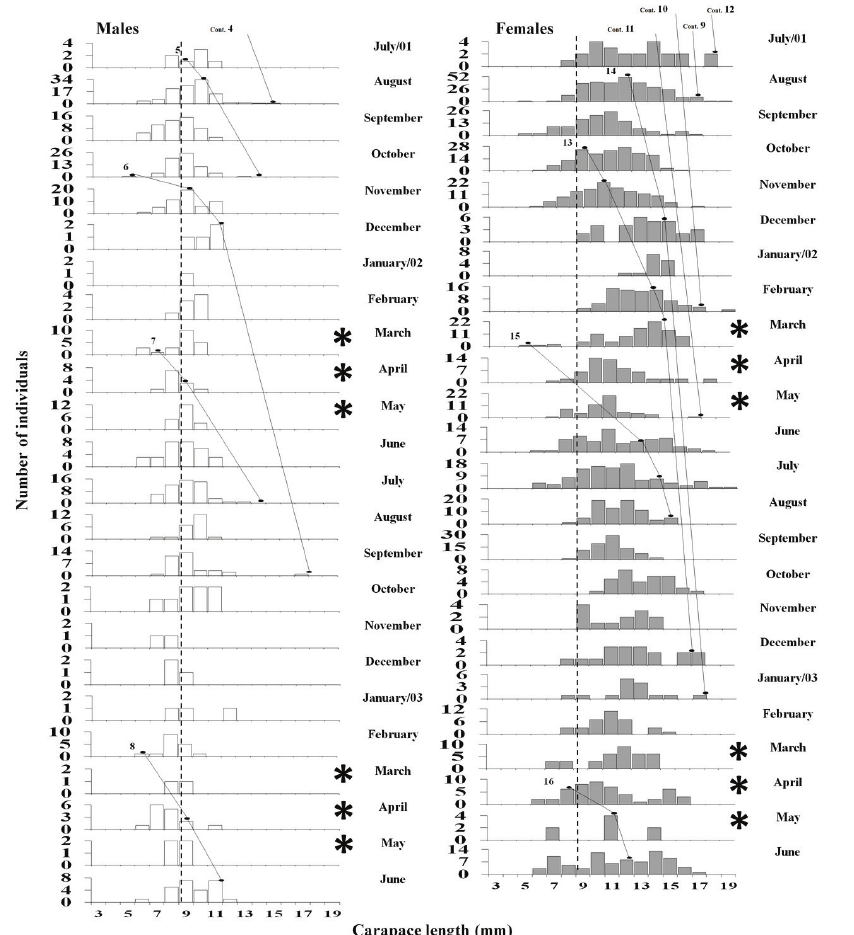
Figure 5 - Rimapenaeus constrictus . Selected cohorts (lines) for growth analyses performed on data sampled from July 2001 to June 2003 at the Northern littoral of São Paulo state. Dotted lines: recruitment size (9.4 mm CL); *: periods in which shrimp-fishing activities are prohibited by the responsible federal environmental